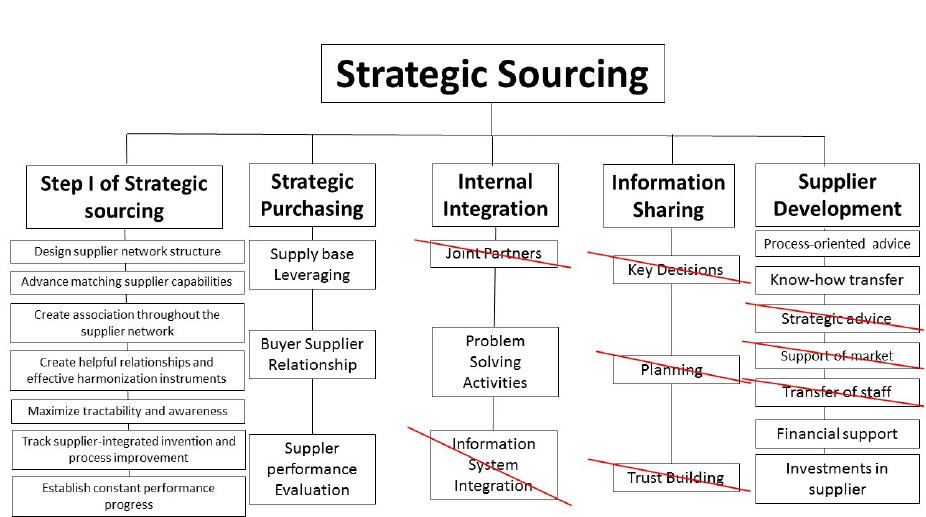
Figure 2: Revised Framework for performance measurement system in strategic sourcing process in footwear supply chain of